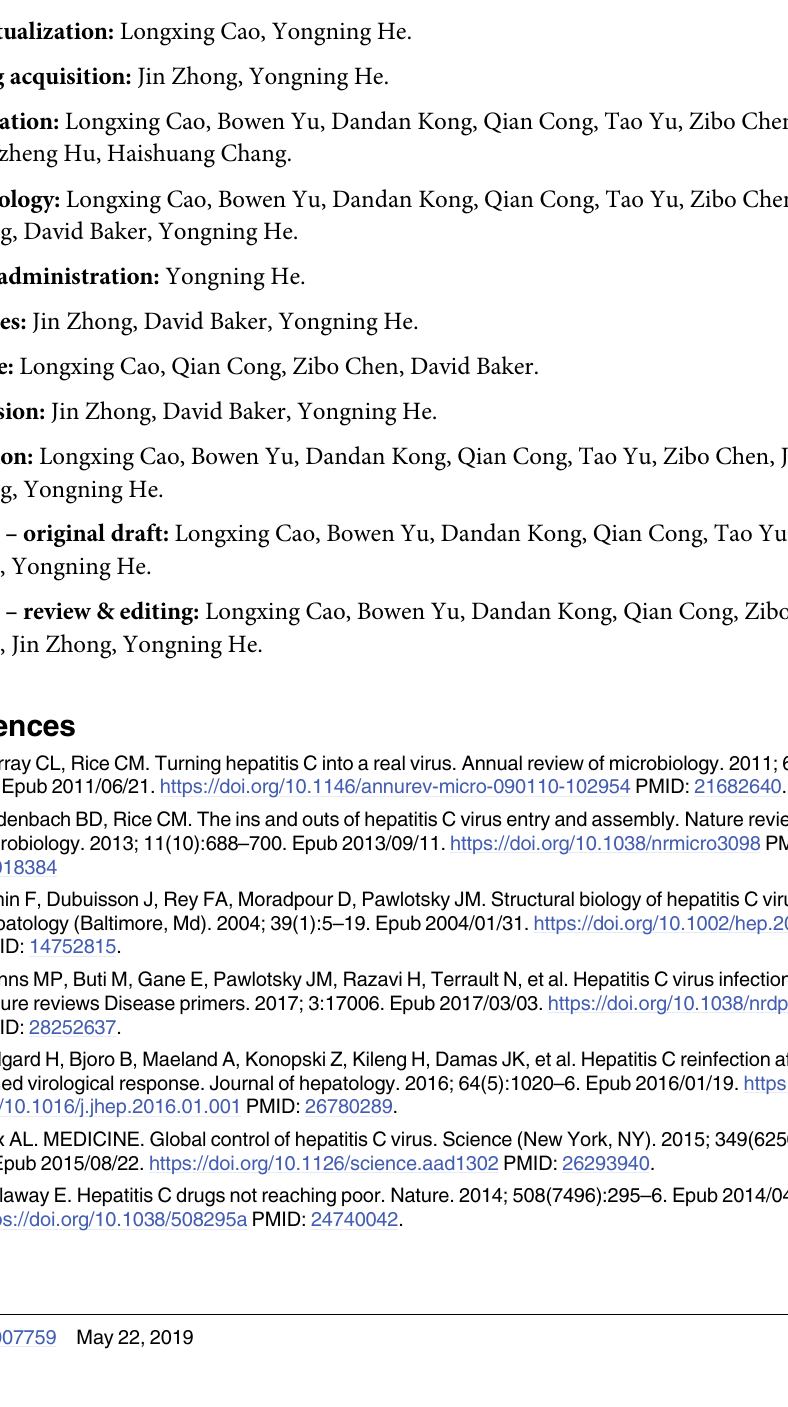
S9 Fig. SDS-PAGE of the purified Fab fragments of neutralizing antibody IGH526 and HCV1 under reducing and non-reducing